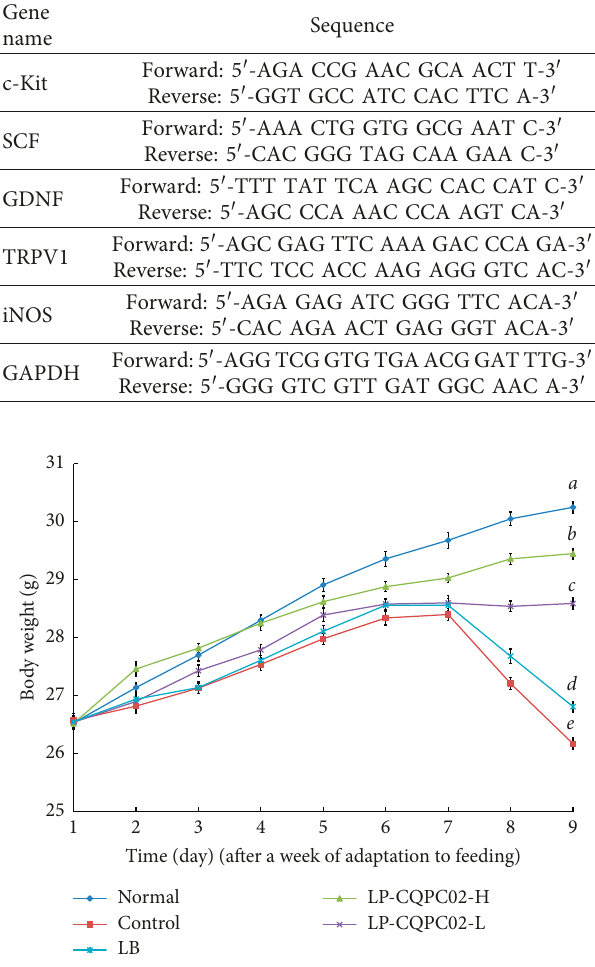
Figure 1: The body weight changes in the mice. Values presented are the mean ± standard deviation. a–e The mean values with different letters in the same bars are significantly different ( p < 0.05) according to Duncan’s multiple-range test; there was no significant difference in the same letter representation between the two bars ( p > 0.05), but there was significant difference in the different letter representation ( p < 0.05). LB : Lactobacillus del- brueckii subsp. bulgaricus (1.0 × 10 9 CFU/kg b.w. gavage); LP- CQPC02-L : Lactobacillus plantarum CQPC02 (1.0 × 10 8 CFU/kg b.w. gavage); LP-CQPC02-H : Lactobacillus plantarum CQPC02 (1.0 × 10 9 CFU/kg b.w.